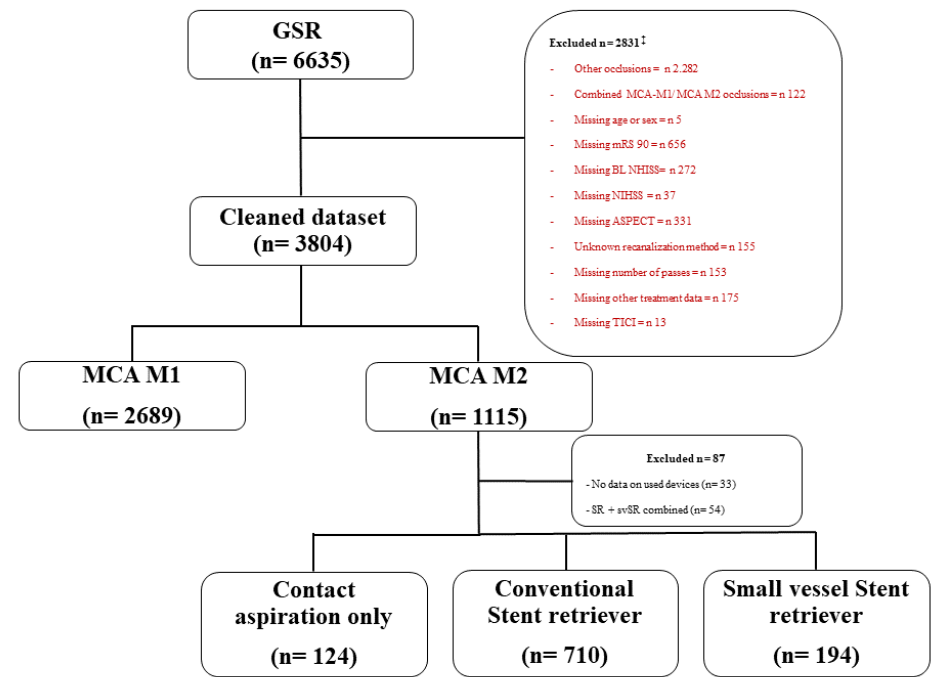
Figure 1. Flowchart of patient selection and exclusion criteria. GSR: German stroke registry; MCA: middle cerebral artery; mRS: modified Rankin Scale; NIHSS: National Institutes of Health Stroke Scale. ‡ multiple missing data within one excluded dataset possible.